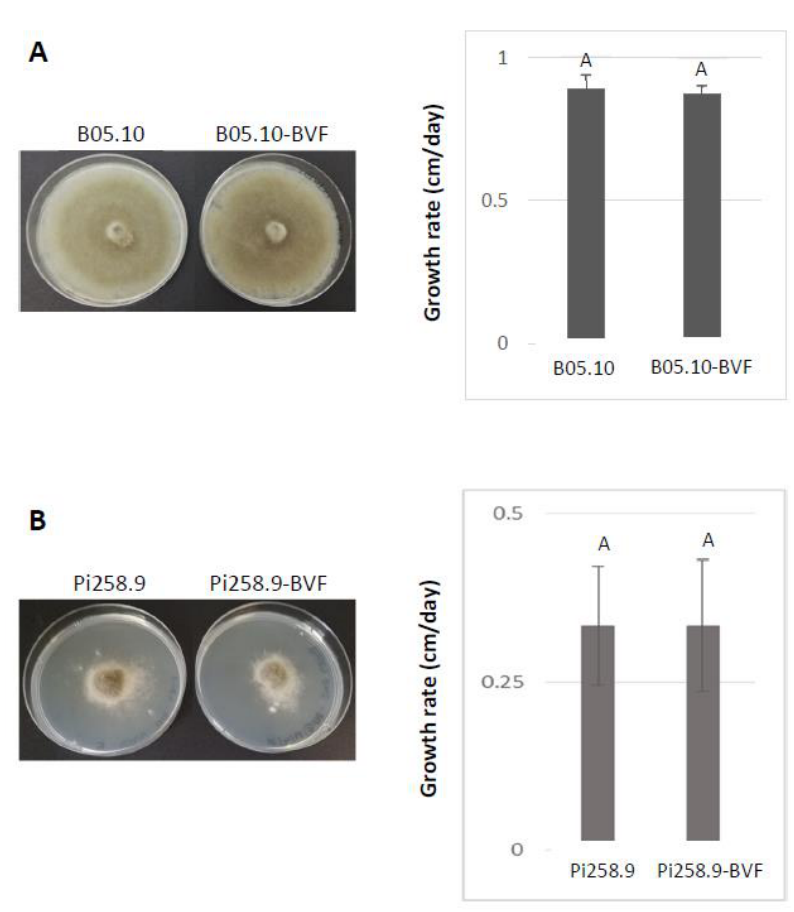
Figure 5. Comparison of phenotype and growth rate of virus-free and BVF-488 –transfected B. cinerea isolates B05.10 and Pi258.9. Comparison of colony morphologies and growth rate on PDA (72 h after inoculation) of virus-free and BVF-488 – transfected B. cinerea strain ( A ) B05.10 and ( B ) Pi258.9.